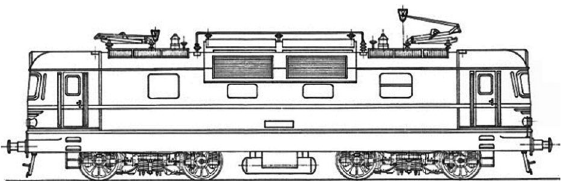
Fig. 1. A sketch of electric locomotive Škoda , series 130